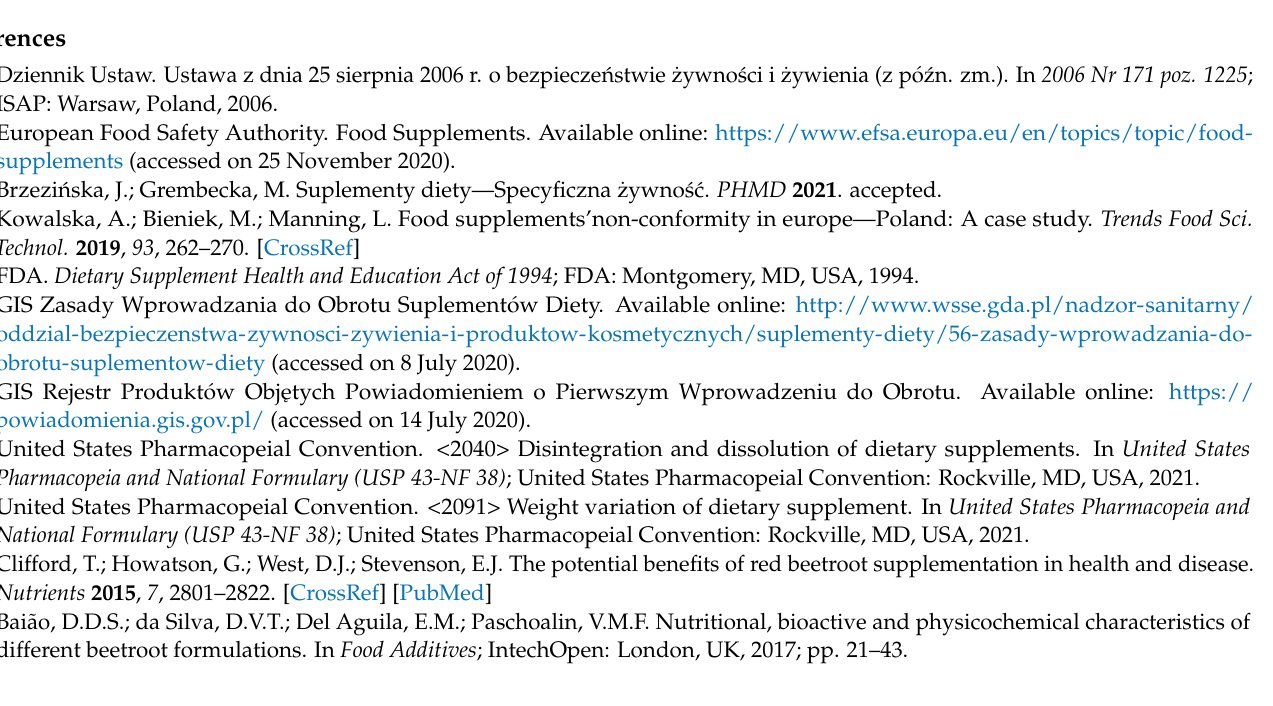
label; Table S2: Iron and zinc content in dietary supplements. Figure S1: A diagram illustrating the experimental